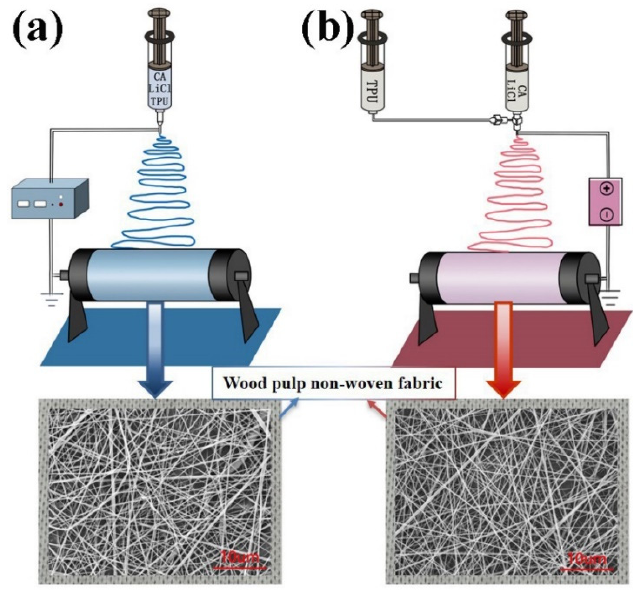
Figure 1. Schematic diagram of electrospinning techniques for fabricating nanofibers. ( a ) Single spinning, ( b ) Coaxial spinning. spinning, ( b ) Coaxial